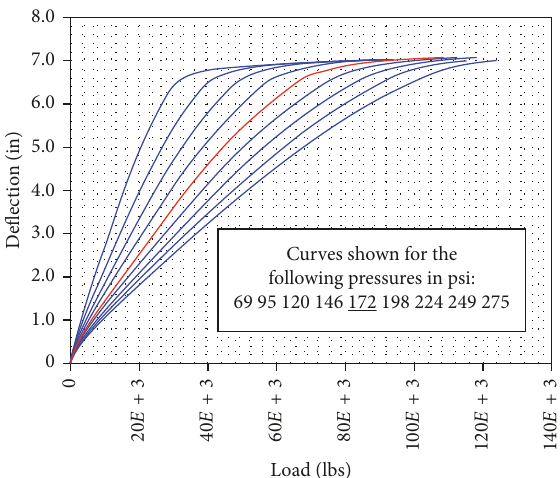
Figure 25: Experimental data of a H38 × 13.0 R18 tyre.